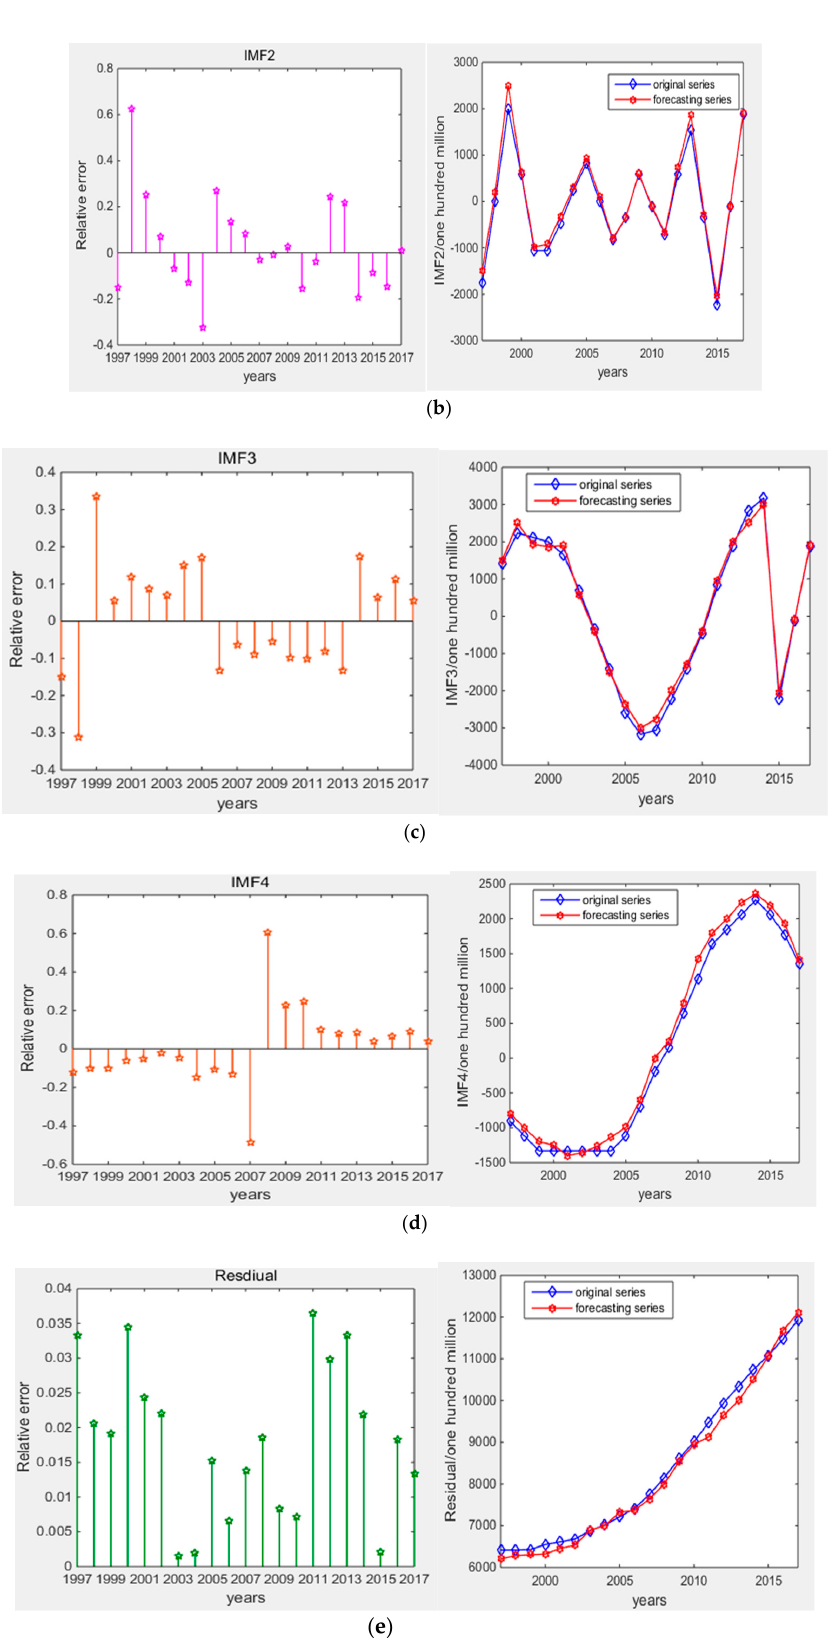
Figure 5. The predicted results of the test sets: ( a ) the predicted results of IMF1; ( b ) the predicted results of IMF2; ( c ) the predicted results of IMF3; ( d ) the predicted results of IMF4; ( e ) the predicted results of